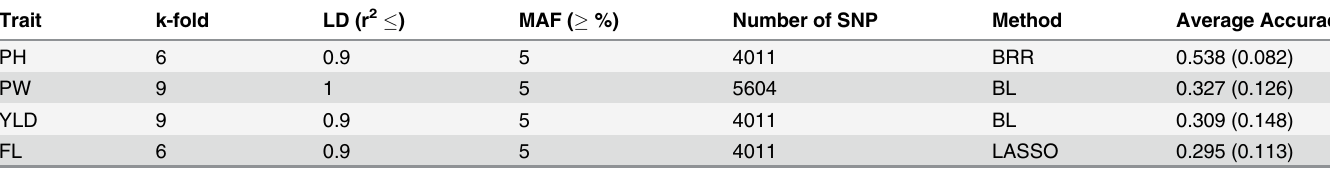
Table 3. Best average accuracies among the 135 GEBVs obtained from the training data sets (TP) and the observed BLUP of the validation data sets (VP) considering each trait. Trait